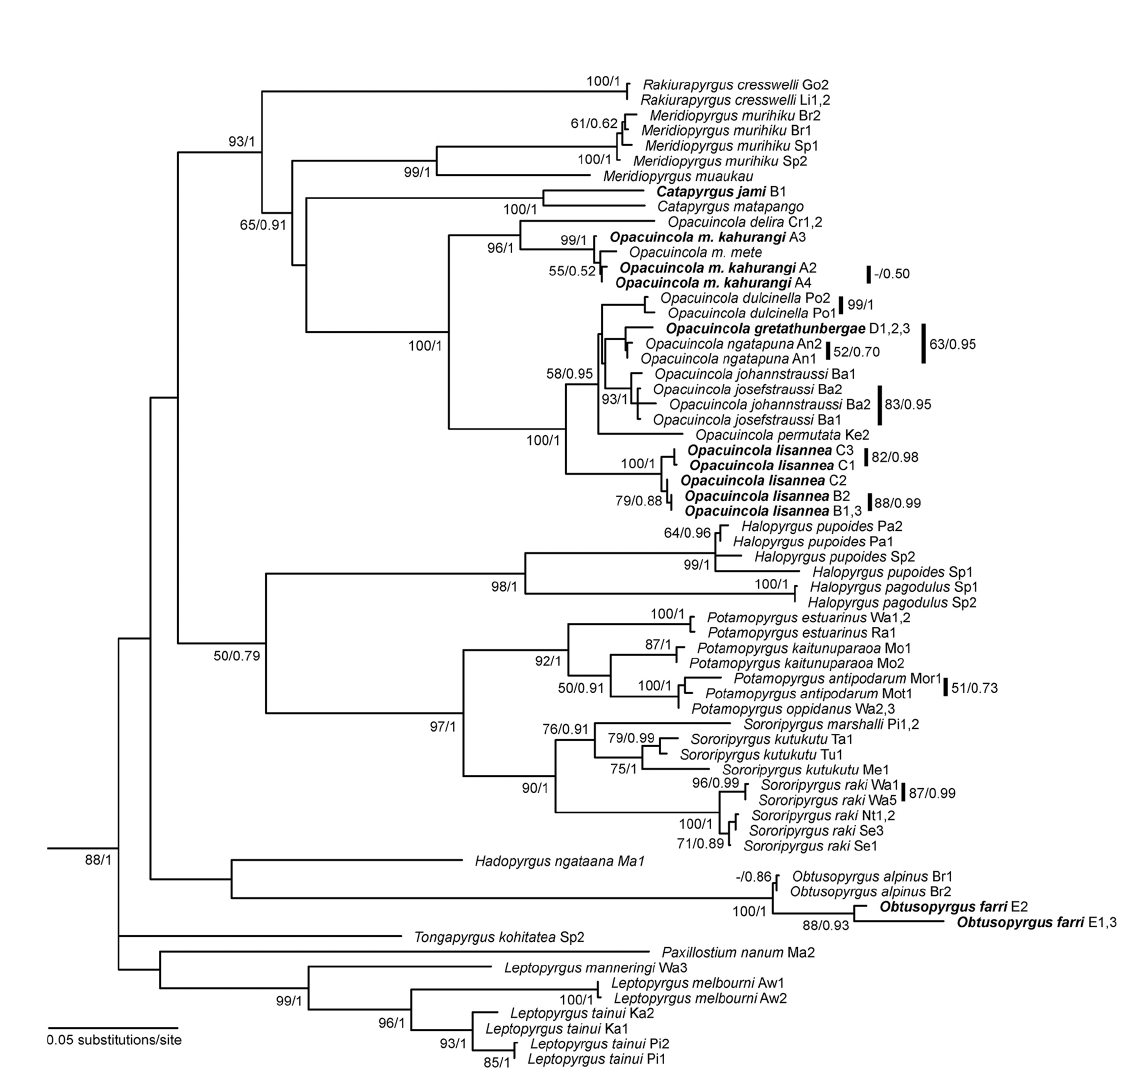
Fig. 2. Phylogenetic analysis. Maximum likelihood tree with bootstrap support > 50 / posterior proba- bilities from Bayesian analysis > 0.50 for nodes. New taxa in bold. Letters A-E after new taxa refer to localities in Figure